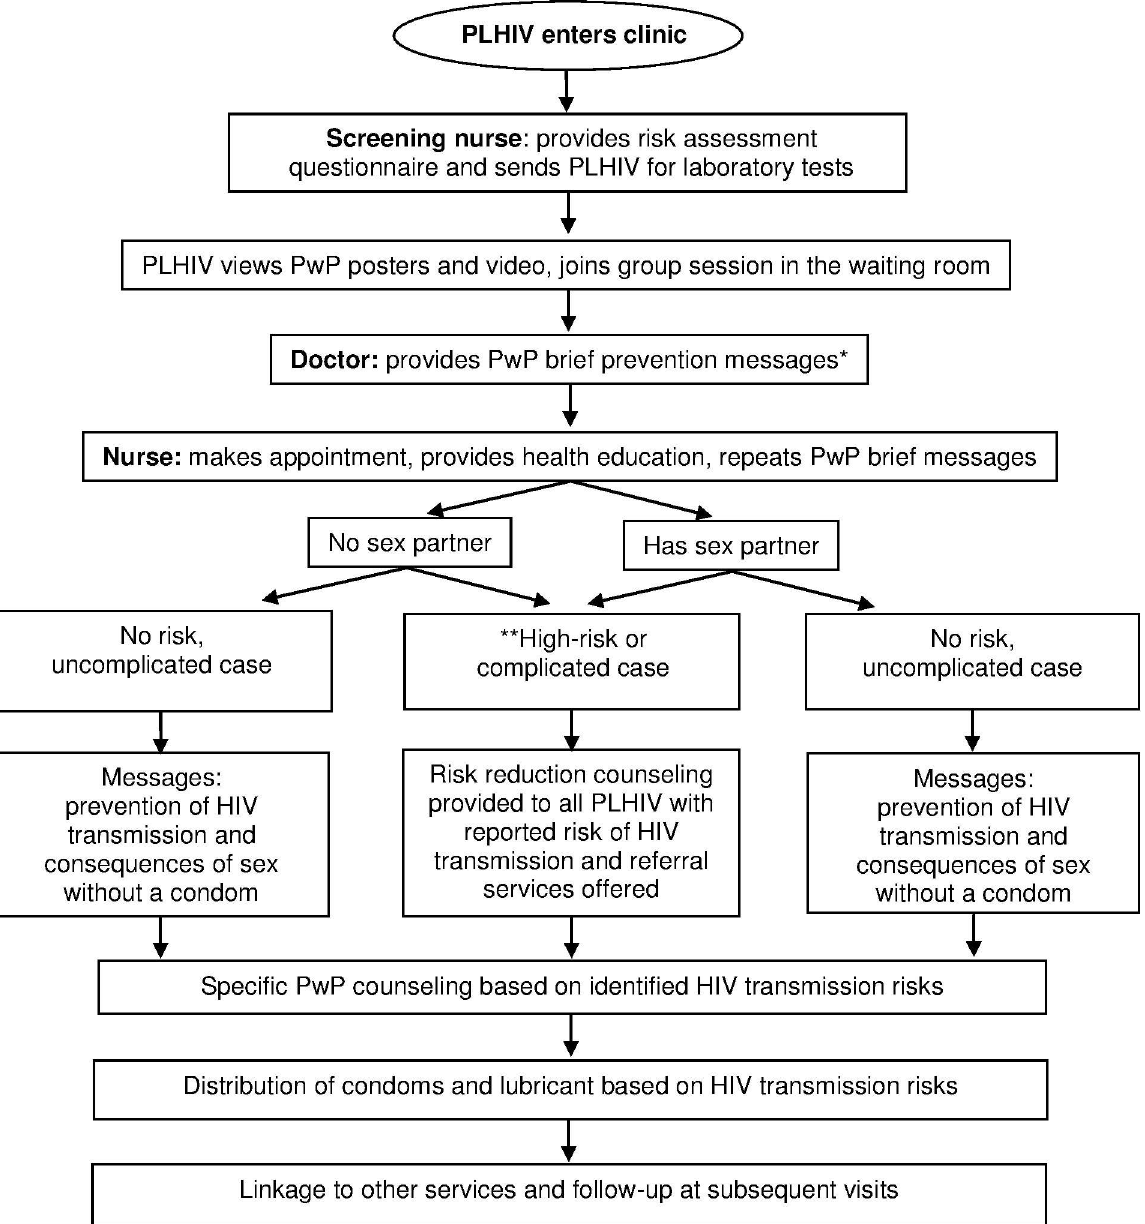
Fig 1. Flowchart of the Prevention with Positives (PwP) program for people living with HIV (PLHIV) in Thai hospitals. * Short preventionmessages are providedto all PLHIV at routine clinicalvisits, coveringall strategies in the initial visit and specific patient- centered strategies at follow-upvisits. ** High-risk/complicated case definedas peoplewho inject drugs who report sharingneedles, peoplewho report sex without a condom, and peoplewho have a history of